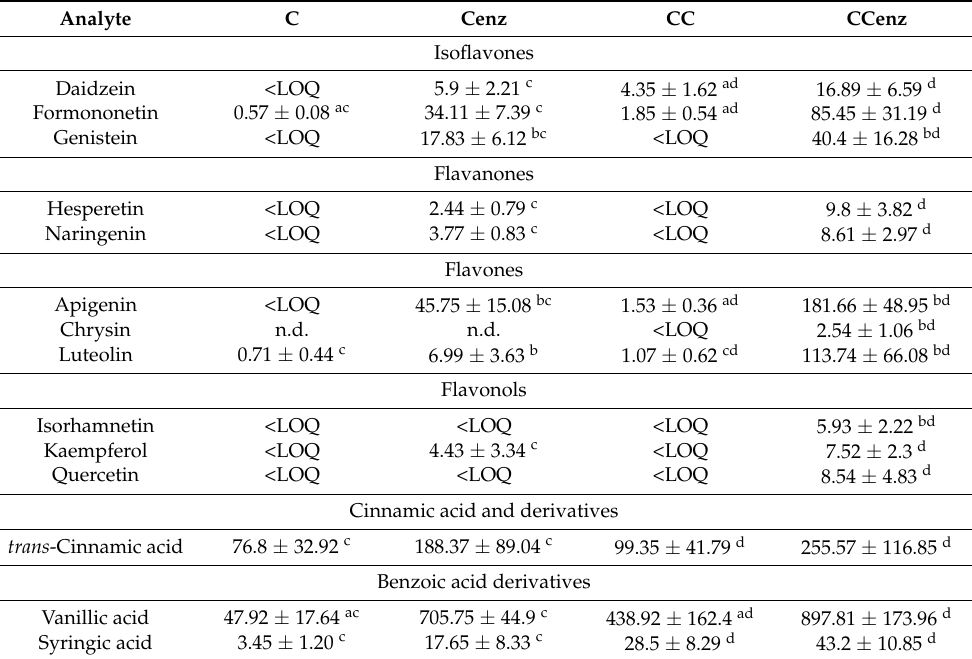
Table 4. Polar phenolic compounds (ng/mL) detected in rat serum samples (n = 6 per group).